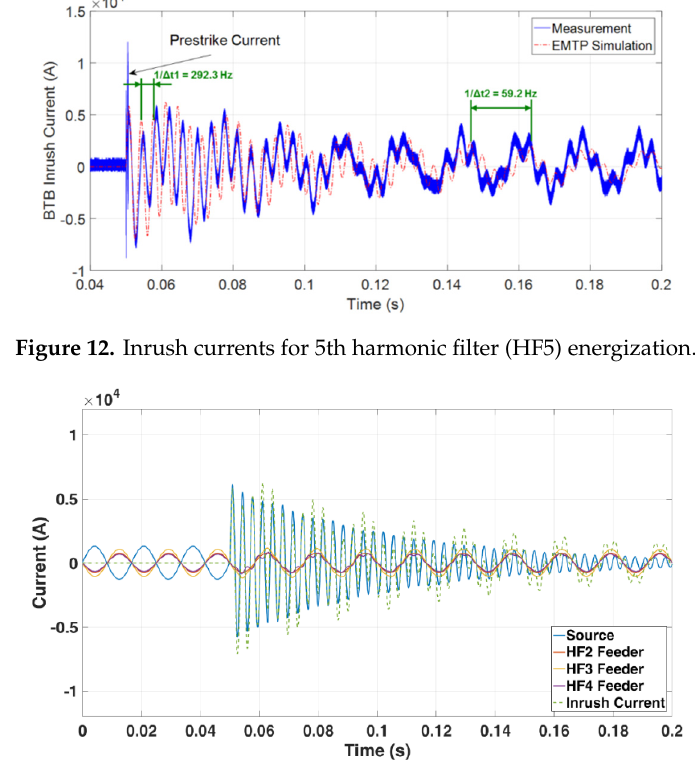
Figure 13. Inrush current and each feeder current for HF5 energization.